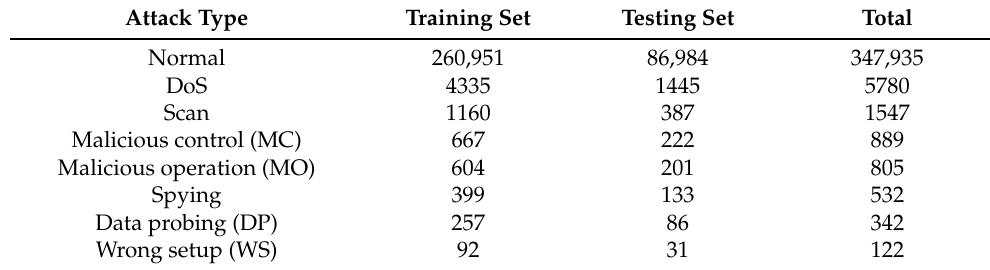
Table 3. Class distribution of DS2OS